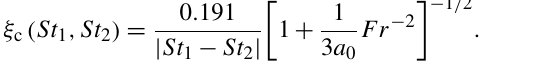
Figure 7. Comparisons of r 3 p -weighted power spectrum E ∗ model for the cases of (a) g = 0 . 0 and (b) 9.8ms − 2